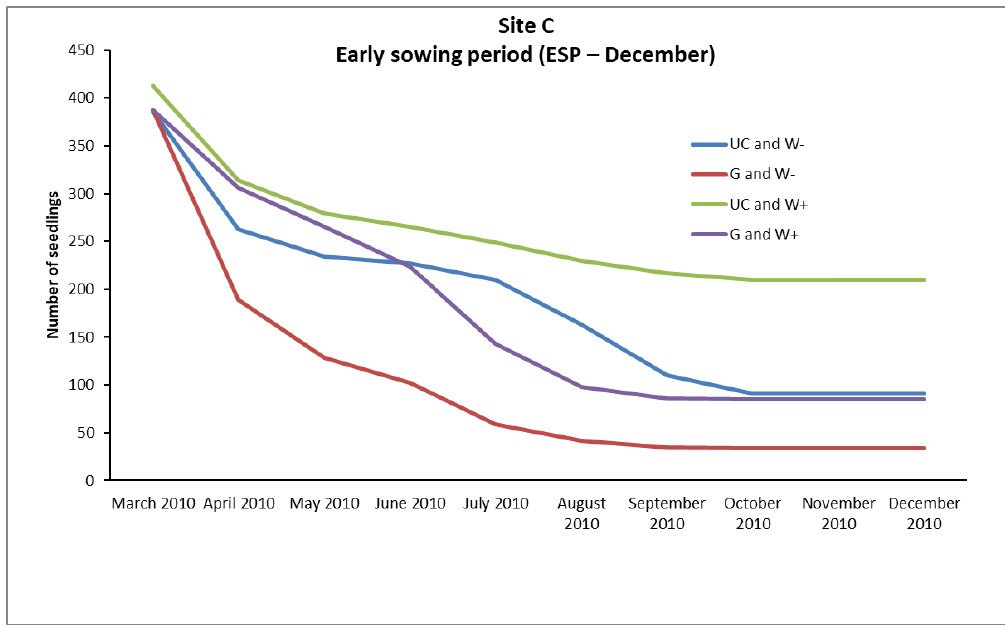
Figure 7. Monthly seedling survival (number of living seedlings) of the December sowing (ESP) in the plots of each combination of the two factor levels in site C for the period March 2010–December 2010 (the March 2010 record shows the number of germinated seeds).